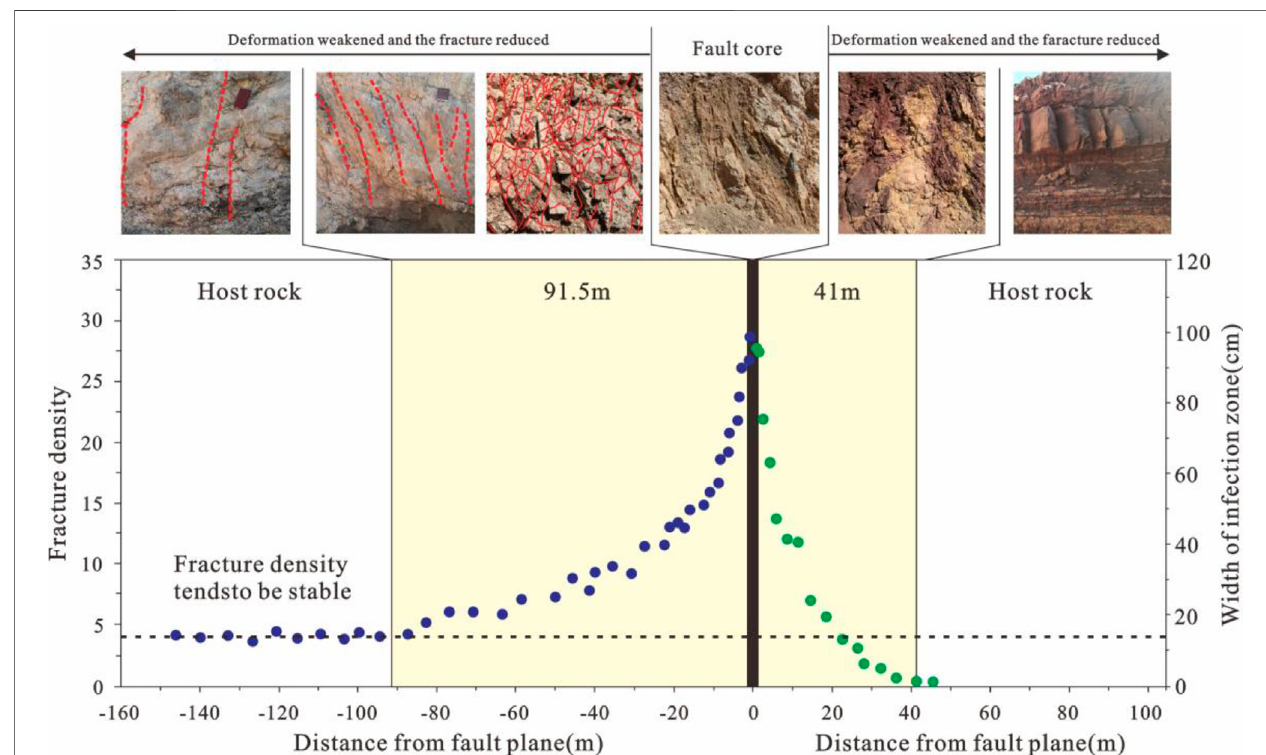
FIGURE 5 | Width of damage zone of the Xike ’ er reverse fault. Fractures in the hanging wall of the fault are developed obviously and footwall fl uid acted obviously. ThebluedotsindicatefracturedensitiesatdifferentlocationsinthehangingwalloftheXike ’ erfault,andthegreendotsindicatethewidthoftheinfectionzonedueto fl uid action. The yellow area is the scope of damage